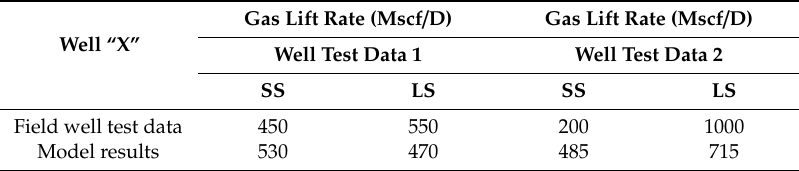
Table 4. Comparison of model results and field well test data.